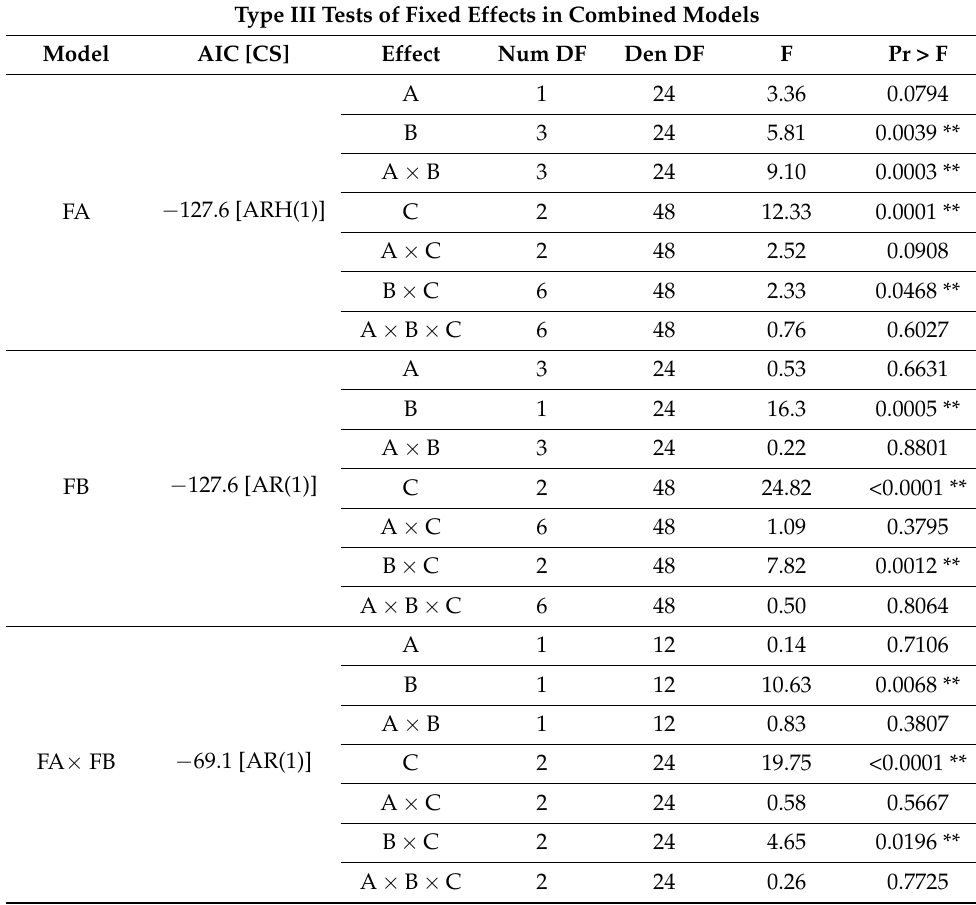
Table 7. Fixed-effects F-tests for the combined models in narrow inference